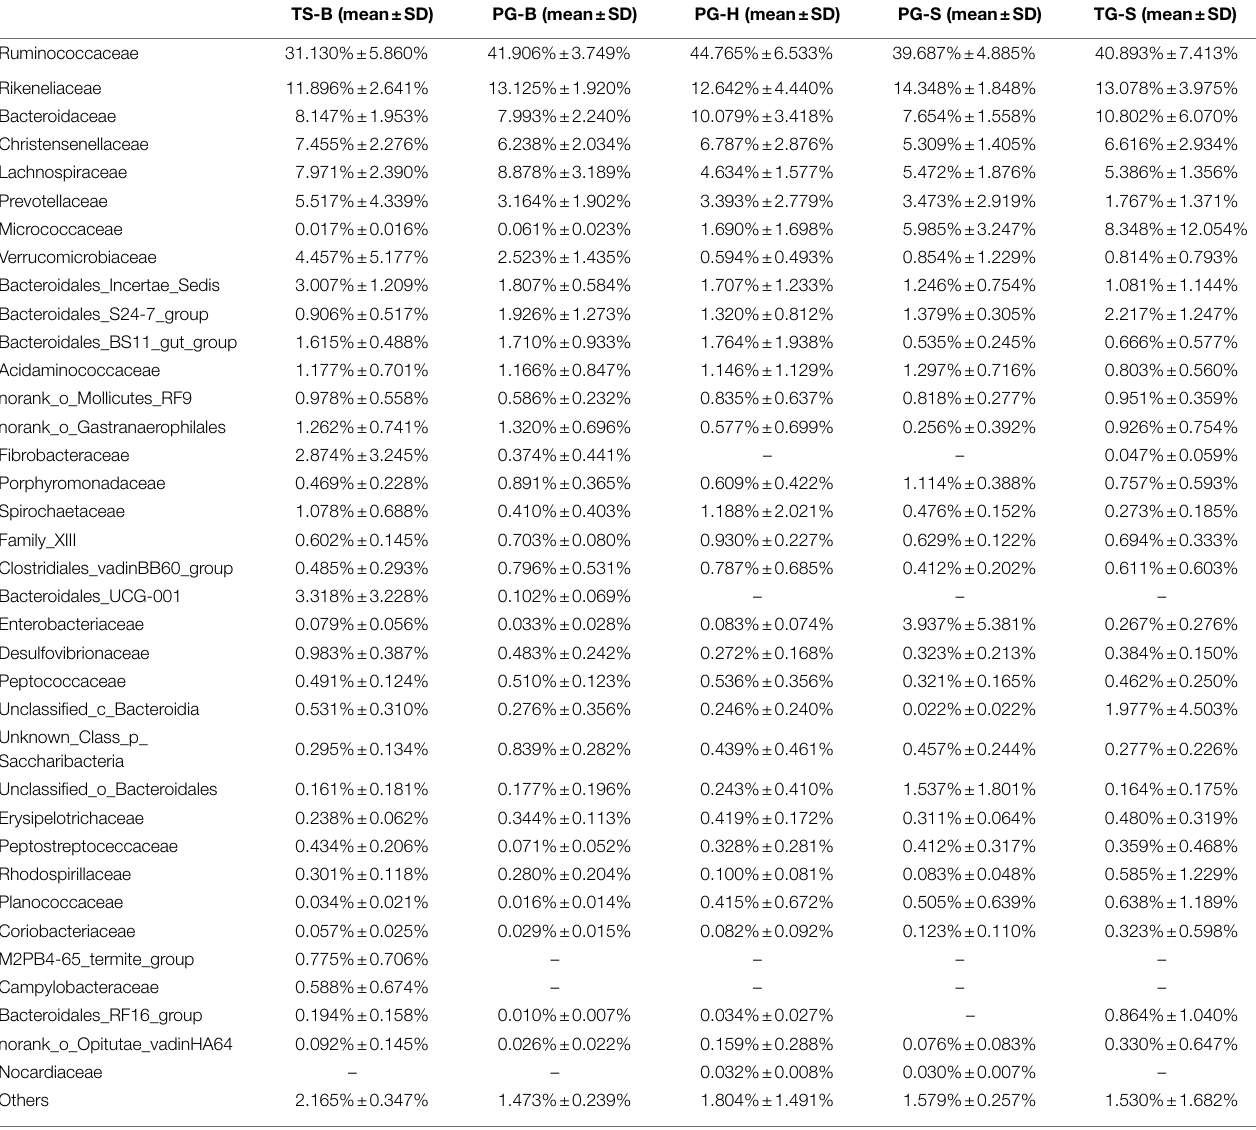
TABLE 3 | Percent of community abundance on family level in each